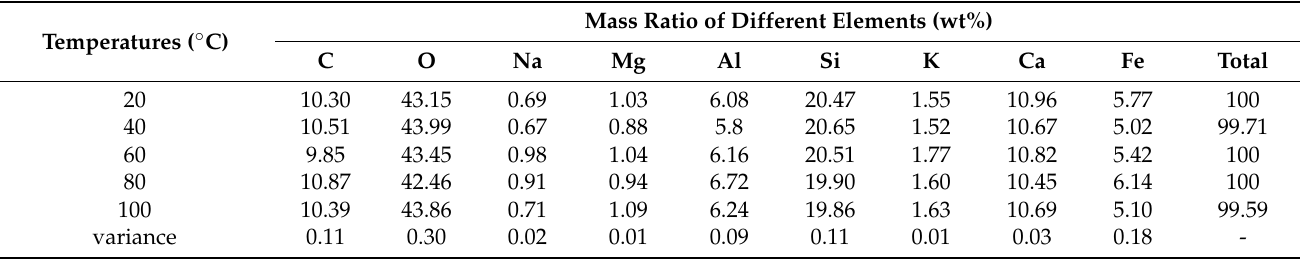
Table 6. Chemical composition of CDWC at different pretreatment